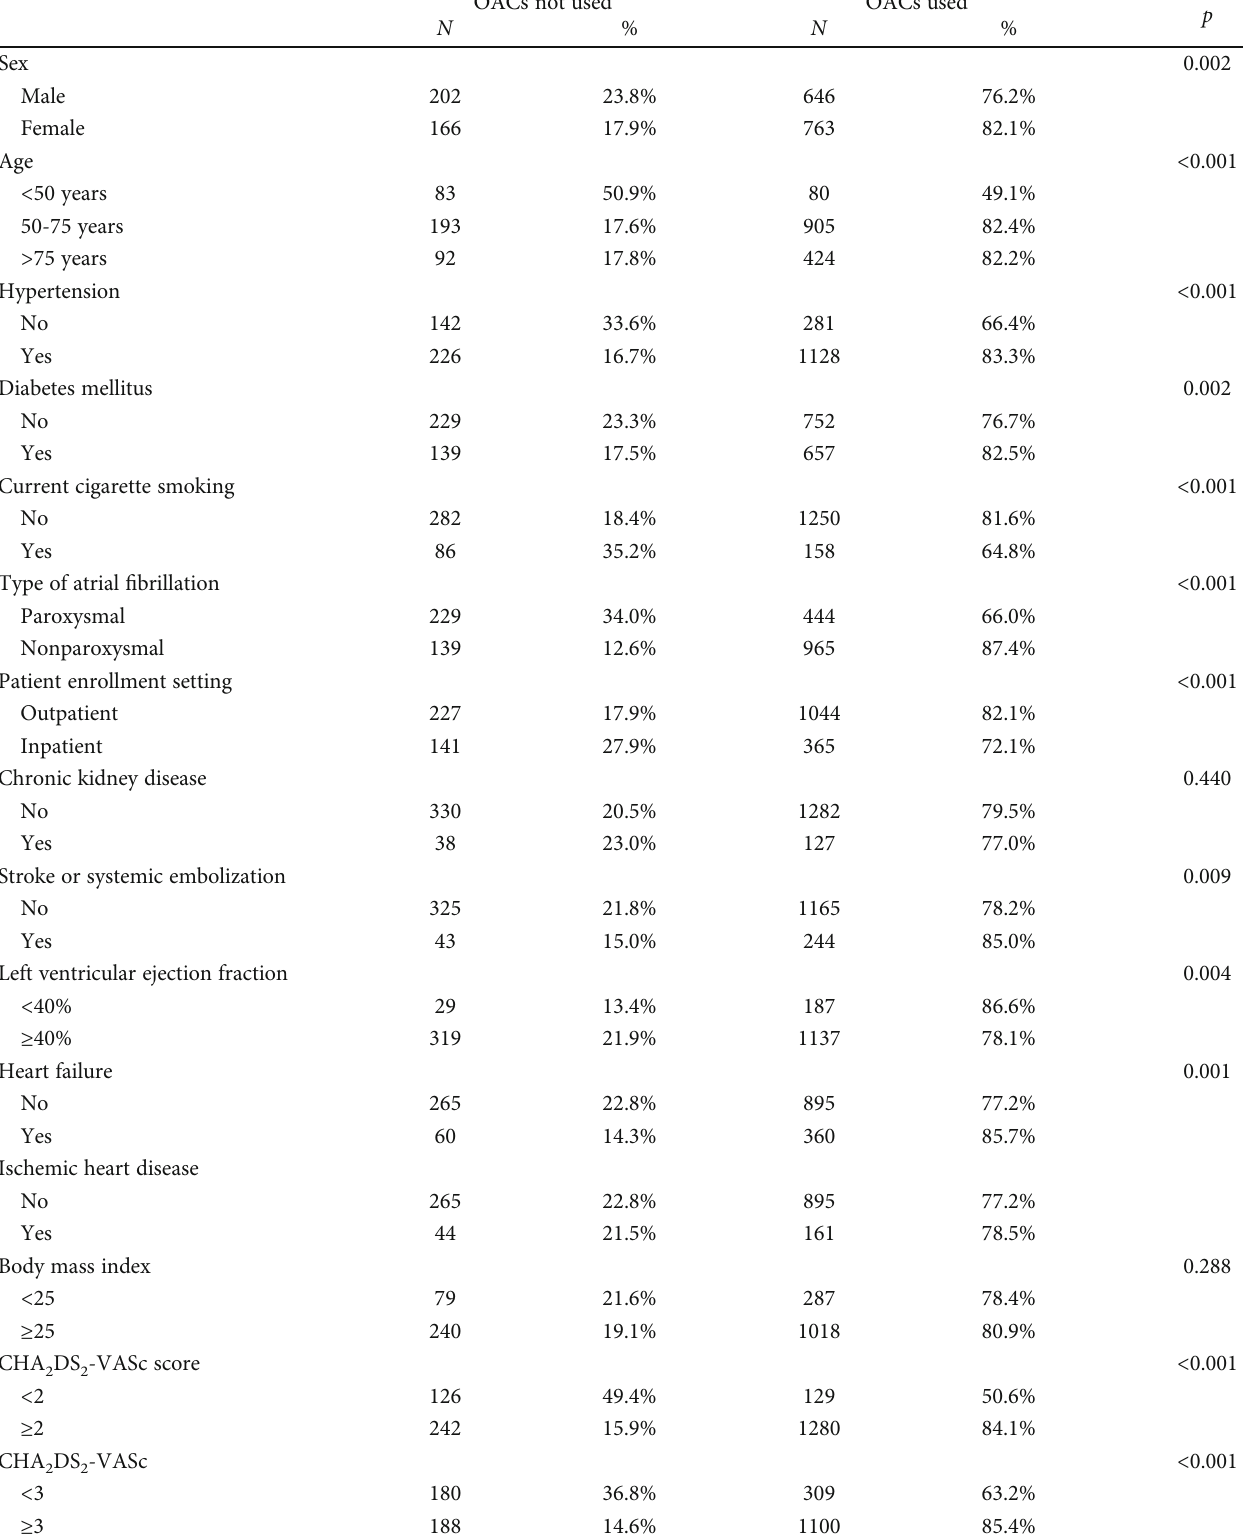
Table 2: Univariate analysis of factors associated with oral anticoagulant agent use among patients with nonvalvular atrial fi